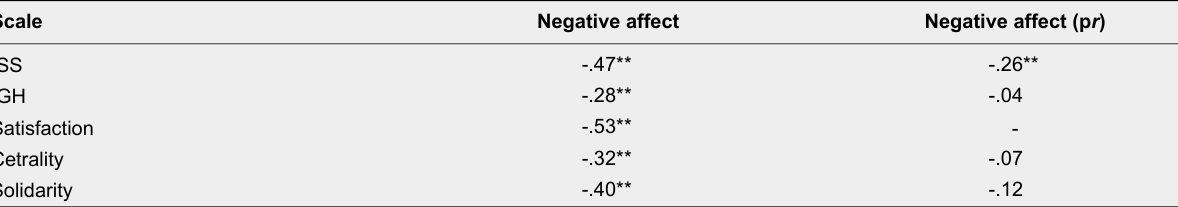
Divergent Validity: Bivariate Correlations With Group Identity Scale (Study